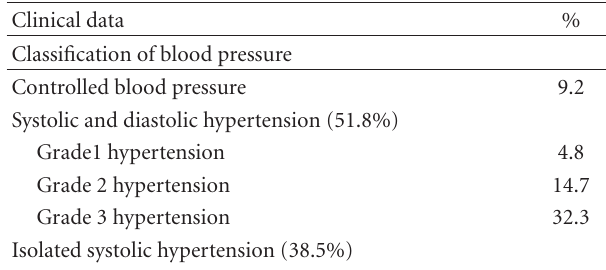
Table 1: Population distribution according to the classification of blood pressure, the other cardiovascular risk factor, and target organ damage at first